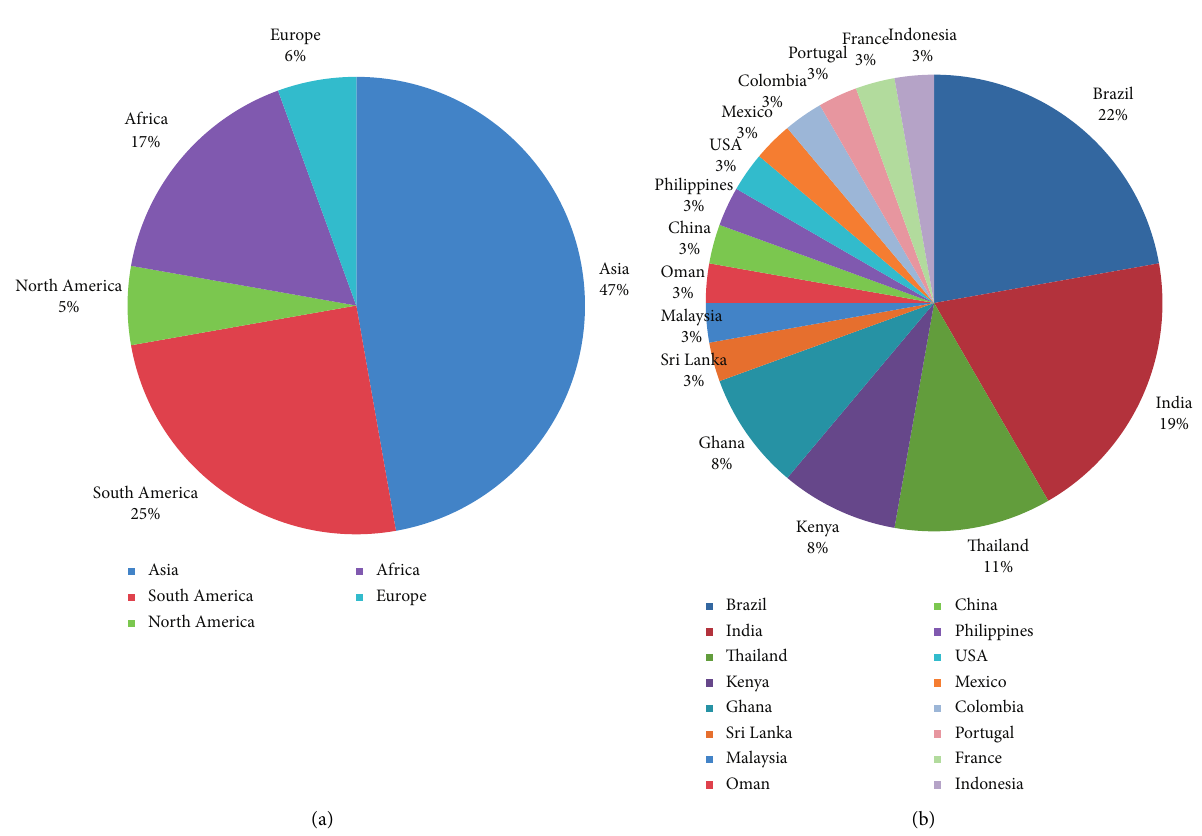
Figure 4: Distribution of relevant published articles ( n � 36) according to different (a) continents (b)